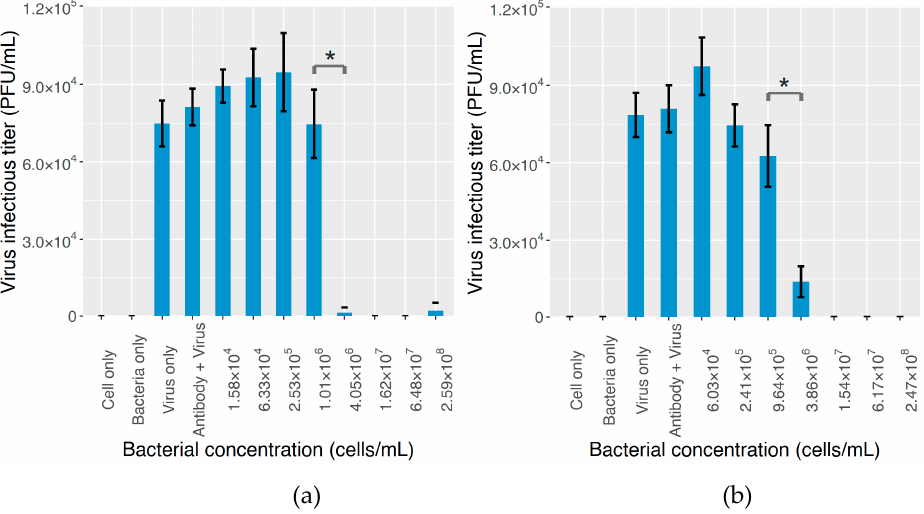
Figure 5. The plaque assay result for the inhibitory effect of bacterial cells on MNV infectivity with the addition of the anti-GD1a antibody. MNV S7 and S. maltophilia B4 were used as the virus and bacterial strain, respectively. The addition of the anti-GD1a antibody was aimed at abating the efficacy of GD1a ganglioside expressed by bacteria, and the disturbed virus–bacterium binding was reflected in the lack of impact on MNV infectivity from bacterial content. ( a ) 0.02 µg/mL antibody was added to the bacterial suspension. ( b ) 2.5 µg/mL antibody was added to the bacterial suspension. Four control groups, “cell only”, “bacteria only”, “virus only”, and “antibody + virus”, were introduced. The meanings of the first three are explained in Figure 3, and in the group of “antibody + virus”, only the anti-GD1a antibody and the virus stock were added to the cell culture.